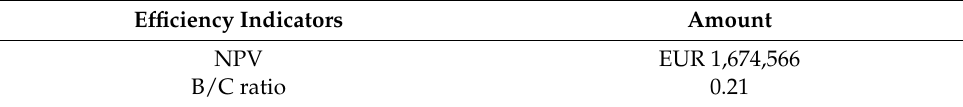
Table 8. Dynamic indicators of financial feasibility of the